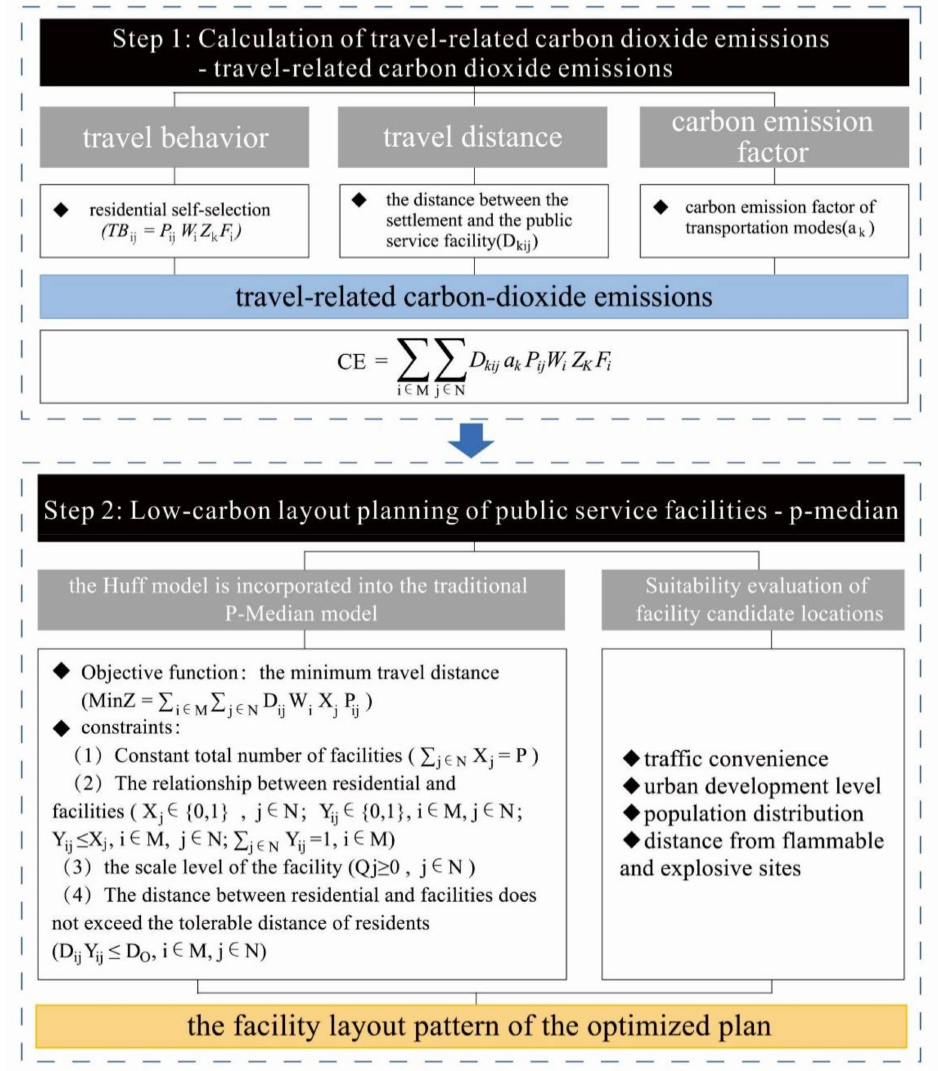
Figure 1. The framework of